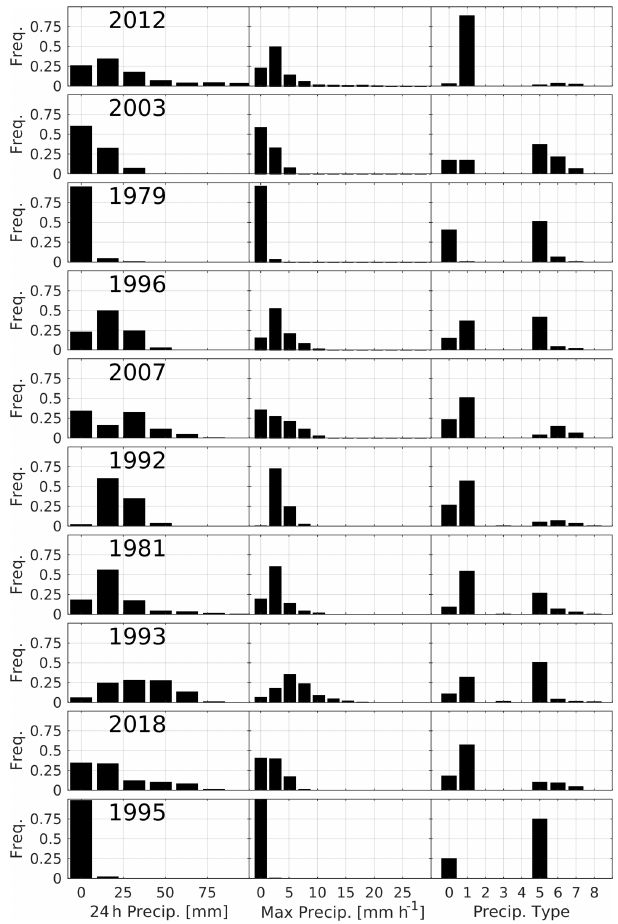
Figure 5. Histograms of precipitation totals and maximum precip- itation rates and precipitation types for the 24h centered on each storm peak. All ERA5 land-based grid cells in the northeastern states which exceed their local U 999 value at any point in the 24h period are included. The frequencies are the fraction of such grid cells in each class. Precipitation types are as follows: no precipita- tion (0), rain (1), thunderstorm (2), freezing rain (3), snow (5), wet snow (6), mixture of rain and snow (7), and ice pellets